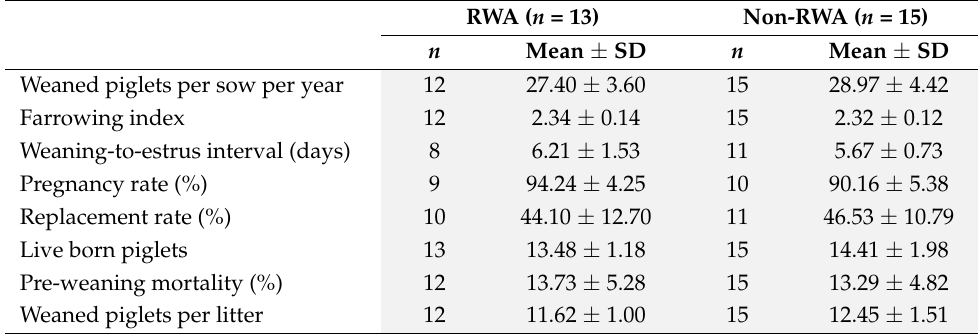
Table 8. The mean ± SD values of the performance parameters on the Raised Without Antibiotics (RWA) ( n = 13) and the non-RWA pig farms ( n = 15). This information was collected on the first farm visit. p values are provided for a comparison between RWA and non-RWA farms based on a parametric independent samples t